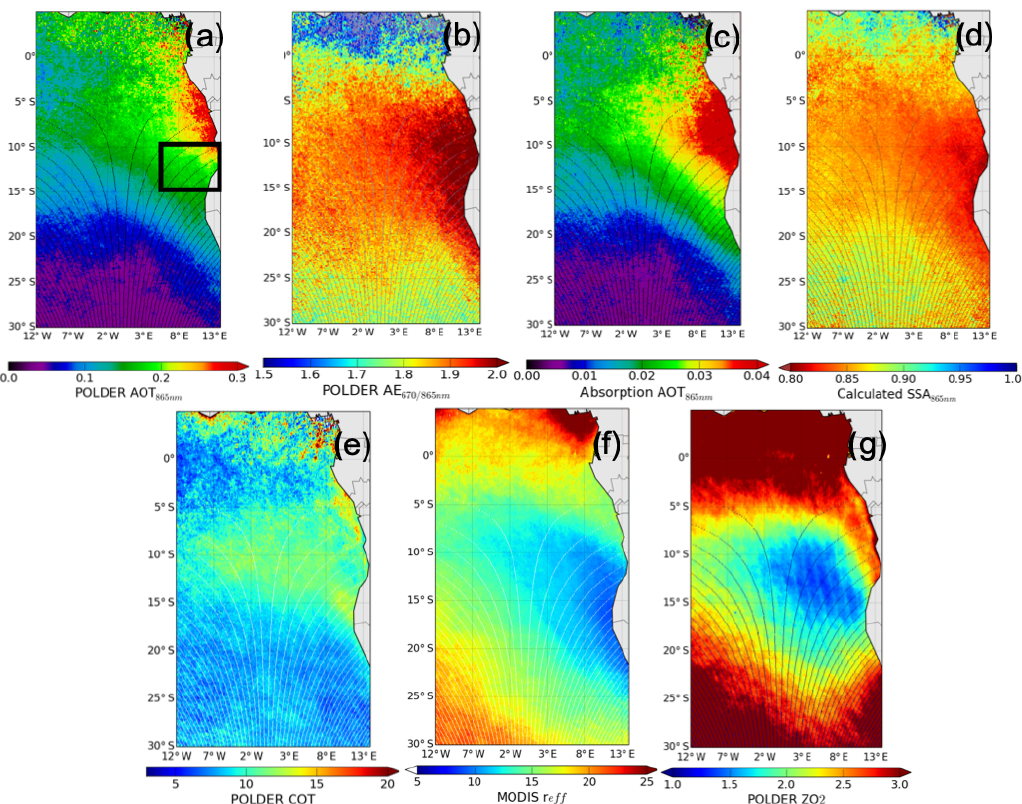
Figure 2. Mean values of above-cloud aerosol and cloud properties above the South Atlantic Ocean, for a period of 6 months (May to October) from 2006 to 2009: (a) POLDER AOT 865nm . The black box represents the sample area close to Angola’s coast described in Sect. 3.2; (b) POLDER AE 670 / 865nm ; (c) POLDER absorption AOT 865nm ; (d) POLDER SSA 865nm ; (e) POLDER COT (corrected for above-cloud absorbing aerosols); (f) MODIS effective radius, r eff (µm); (g) POLDER cloud altitude (ZO 2 ) derived from oxygen pressure